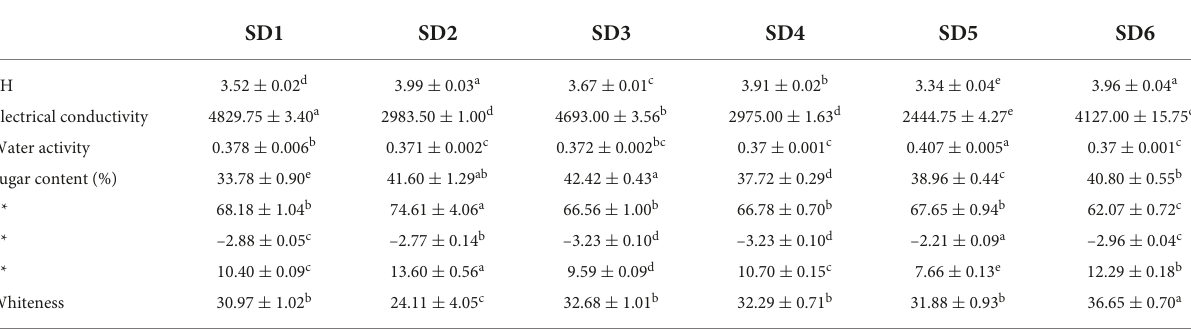
TABLE 2 Analysis of the physical properties of different sweet salad dressings.